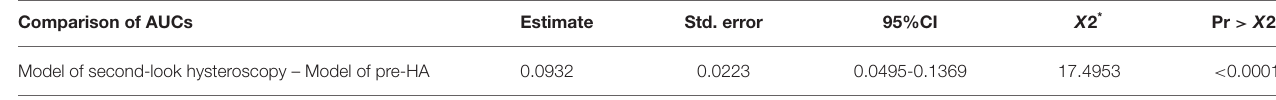
TABLE 3 | Comparison of the areas under the curves of the prediction models. Comparison of AUCs Estimate Std. error